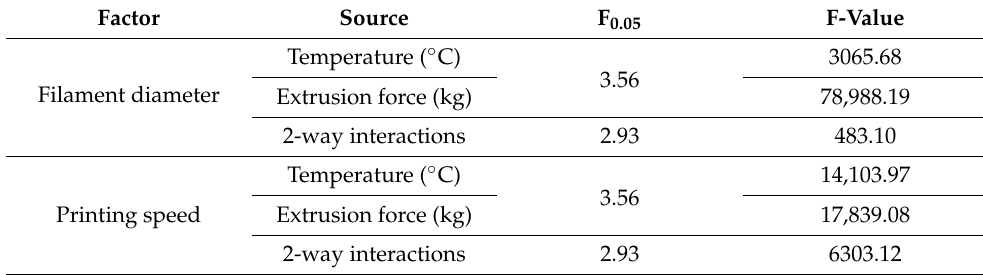
Figure 7. Residual plots of filament diameters: ( a ) normal probability plot of filament diameters; ( b ) normal probability plot of printing speed. Table 2. Analysis of variance for filament diameters and printing speed.